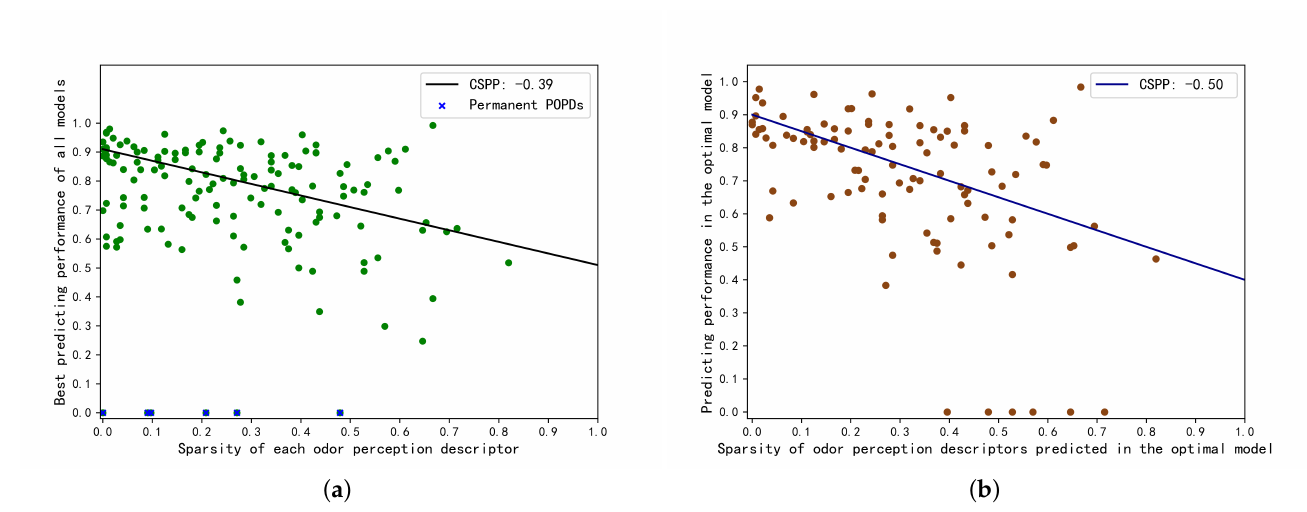
Figure 12. The scatter plot of the relationship between the predicting performance and the sparsities of the odor descriptors in the optimal configuration. CSPP is the abbreviation for the correlation between sparsities and predicting performance. ( a ) Scatter plot of best predicting performance under the optimal configuration and sparsity of each of the 146 odor perception descriptors. ( b ) Scatter plot of the predicting performances and sparsities of the 105 NCCOPDs in the optimal model.